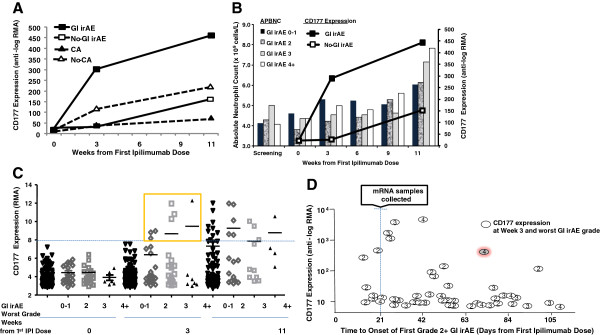
CD177 expression during ipilimumab treatment. (A) Mean expression of CD177 during ipilimumab treatment in patients who experienced grade 2+ gastrointestinal immune-related adverse events (GI irAE), or did not (No-GI irAE). Mean gene expression in patients showing clinical activity (CA) or not (No-CA) also are plotted; (B) Mean expression of CD177 during ipilimumab treatment in patients who experienced grade 2+ GI irAE, or did not (No-GI irAE), and mean absolute peripheral blood neutrophil counts (APBNC) during the same time period, by worst-grade GI irAE (bars); (C) CD177 expression level (RMA-normalized value) versus worst-grade GI irAE, by sample-collection time; (D) CD177 expression level (anti-log RMA-normalized value) at week 3 versus time to onset of first grade 2+ GI irAE. Numbers in the circles describe the worst grade of GI irAE reported during the course of treatment. Highlighted circle represents CD177 expression in the patient who experienced a fatal grade-4 GI irAE.